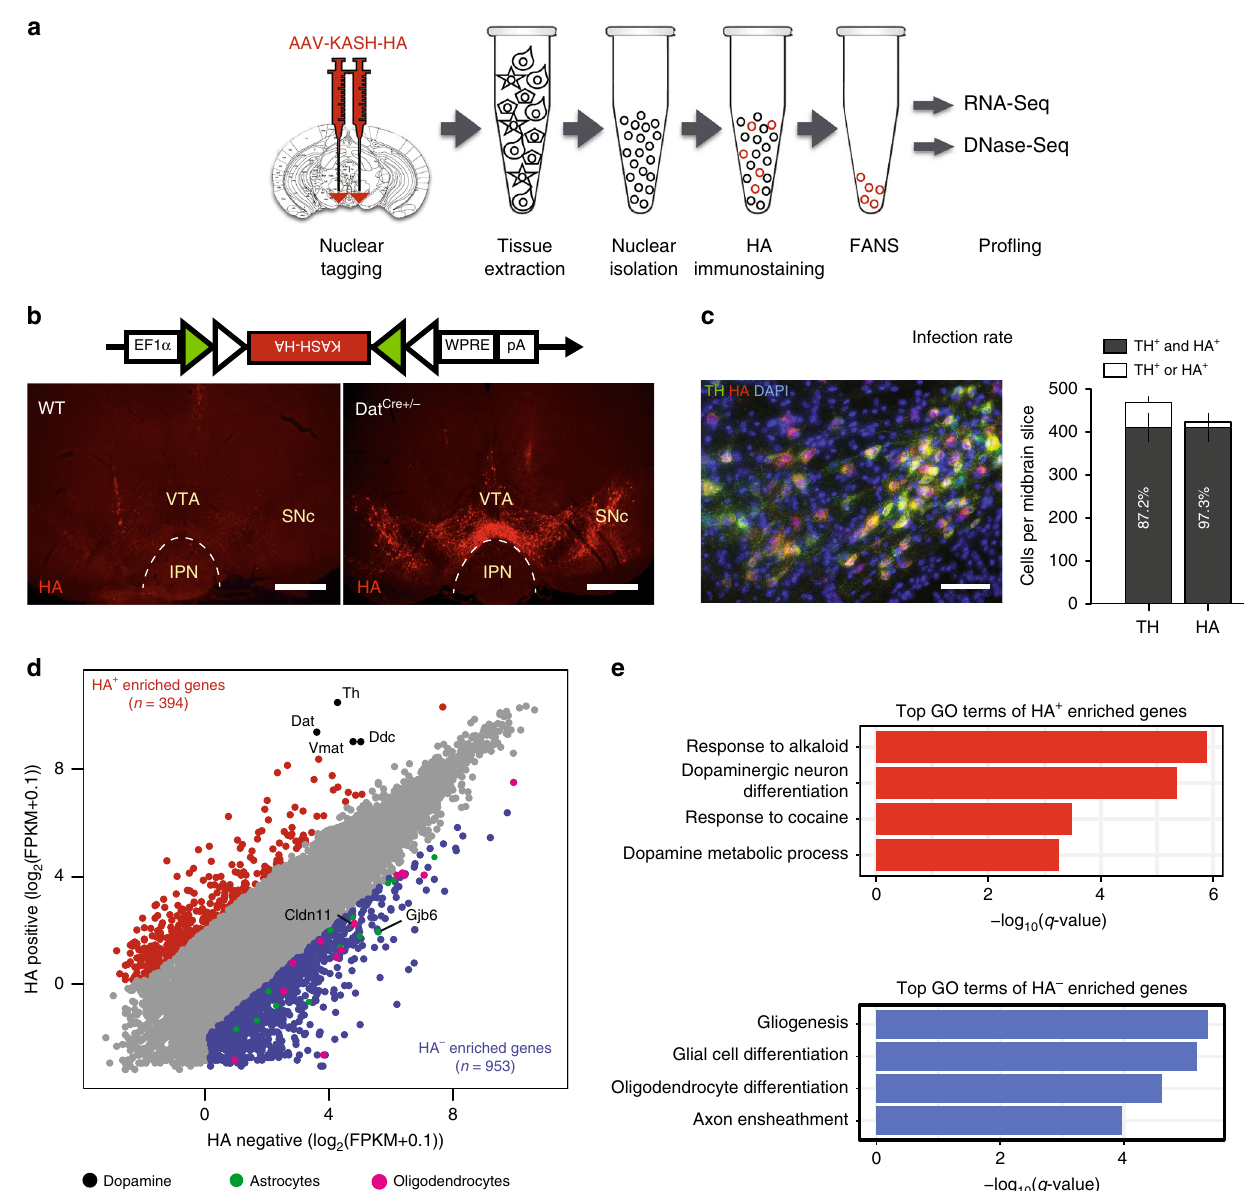
Fig. 1 Neuron subtype-speci fi c nuclear capture and transcriptome analysis. a Schematic illustration of the experimental steps for mDA nuclear capture. AAV-DIO-KASH-HA (DIO-KASH-HA) is bilaterally injected into the midbrain of Dat-Cre het mice. Two weeks later, midbrains are dissected and nuclei are isolated by Fluorescence Assisted Nuclear Sorting (FANS). The isolated nuclei were then used for multi-omics analysis. Note: Needle/syringe image was adapted from Keynote clipart, and coronal brain section was reproduced from ref. 48 . (Copyright 2013, Elsevier, Academic Press). b Diagram of the DIO- KASH-HA vector (top) and representative micrographs illustrating infection speci fi city to Cre-expressing neurons. WT mice injected with DIO-KASH-HA virus showed no HA signal (bottom left) as opposed to Dat-Cre het mice (bottom right). Scale bar: 500 μ m. c Merged representative micrograph (left) showing near-complete colocalization of HA signal (red) with TH + neurons (green). Scale bar: 50 μ m. Histogram (right) illustrating infection ef fi ciency (mean ± s.e.m.) of DIO-KASH-HA construct ( n = 6). 87.2% of DA neurons were infected by DIO-KASH-HA, while 97.2% of DIO-KASH-HA-infected neurons were DAergic. d Scatter plot comparing RNA-seq data of HA + and HA − nuclei indicating HA + nuclei are enriched for DAergic markers (black), and depleted of astrocyte (green) and oligodendrocyte (magenta) markers. HA + nuclei enriched genes are marked in red. Segregation criteria: fold-change > 4; FPKM> 1. e Enriched GO terms associated with the 394 HA + and 953 HA − nuclei enriched genes, respectively ( q- value <